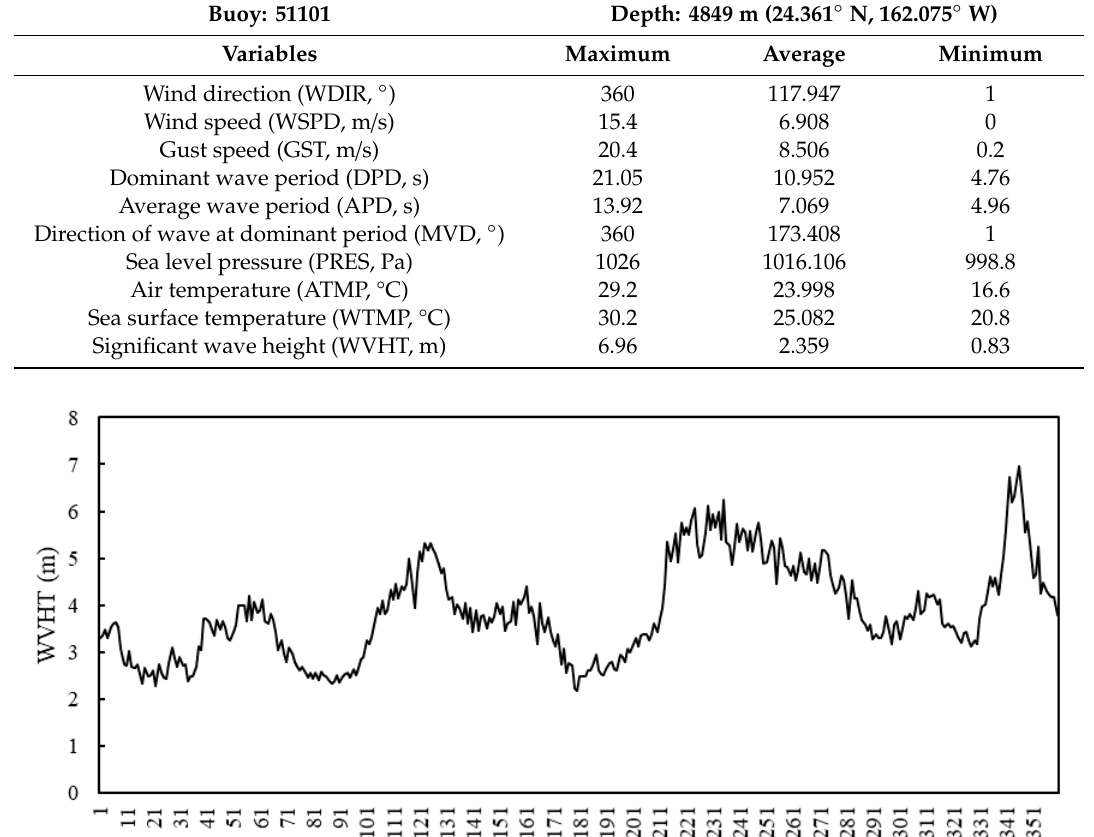
Table 1. Information and summary of measured data from buoy 51101.